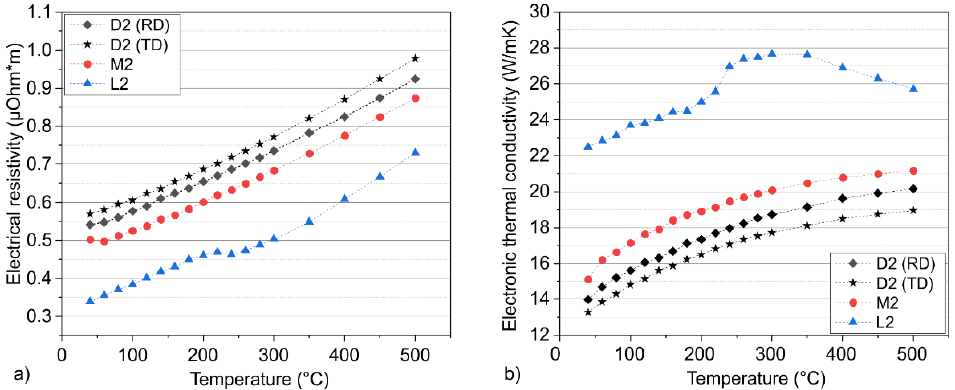
Figure 4. Electrical properties as a function of temperature, regarding the ( a ) resistivity and ( b ) elec- tronic thermal conductivity.